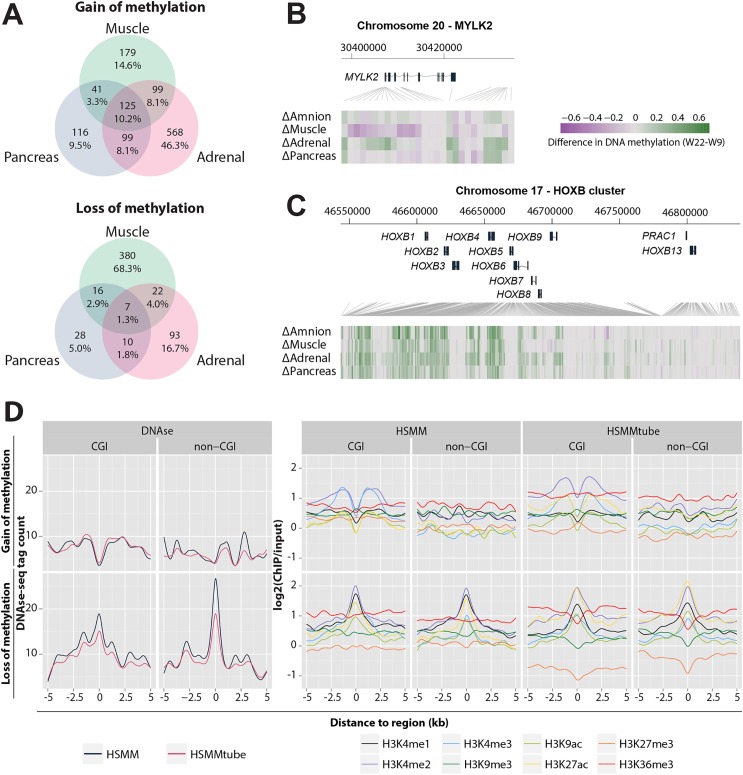
Association of gain and loss of DNA methylation, DNAse I hypersensitive sites and histone modifications.(A) Venn diagram visualizing the overlaps between genes with a gain and a loss of methylation of the three embryonic tissues. (B) Methylation difference between W9 and W22 of MYLK2 in the four tissues. (C) Methylation difference between W9 and W22 of the HOXB cluster. (D) Mean DNAse I hypersensitive (DHS) and histone modifications signals in a 5 kb flanking region of the muscle dDMRs in HSMMs and HSMMtubes. HSMM, human skeletal muscle myoblasts; HSMMtube, human skeletal muscle myotubes.